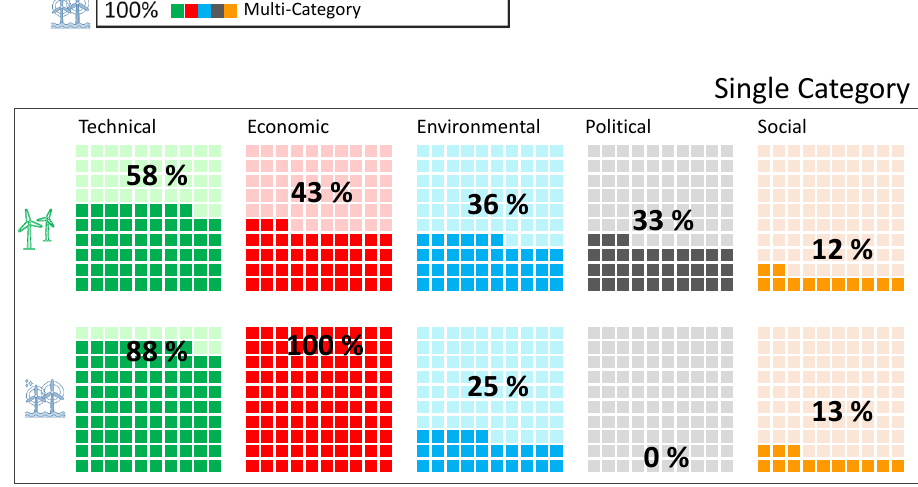
Figure 7. Analysis by categories. First line: Onshore wind power plants. Second line: Offshore wind power